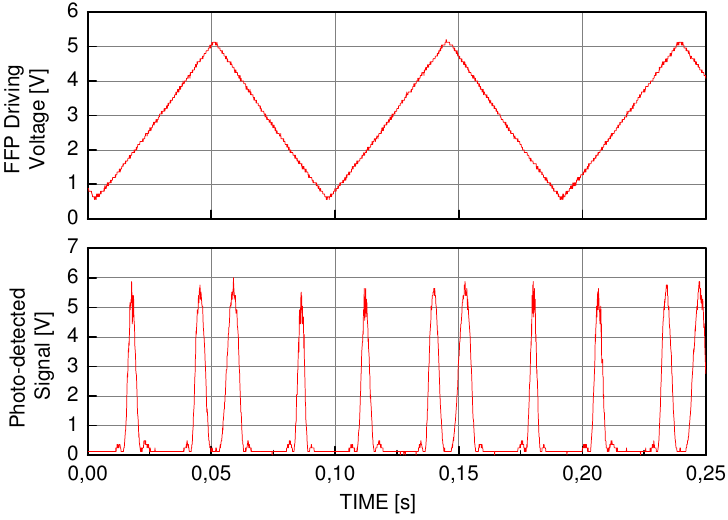
Figure 2. Representation of the tuning waveform and the photo-detected signal corresponding to the two FBG sensors. The signal is time-based and must be converted to wavelength based on the FBG sensors Bragg